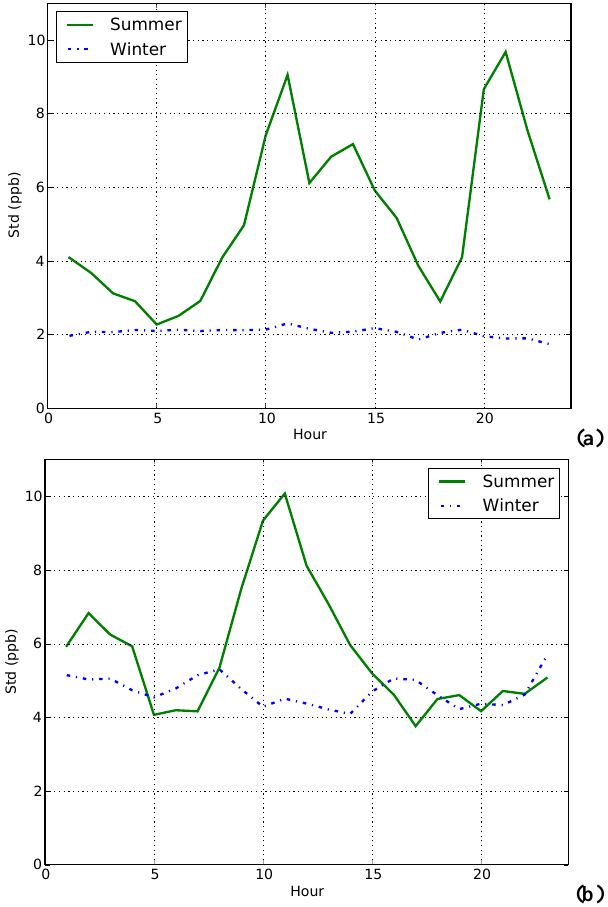
Fig. 7. Time series of estimated standard deviations (in ppb), hourly-averaged in the period between 1 and 10 July 2010 and in the period between 1 and 10 December 2010 in the grid cells of Paris (a) and Grenoble (b) .